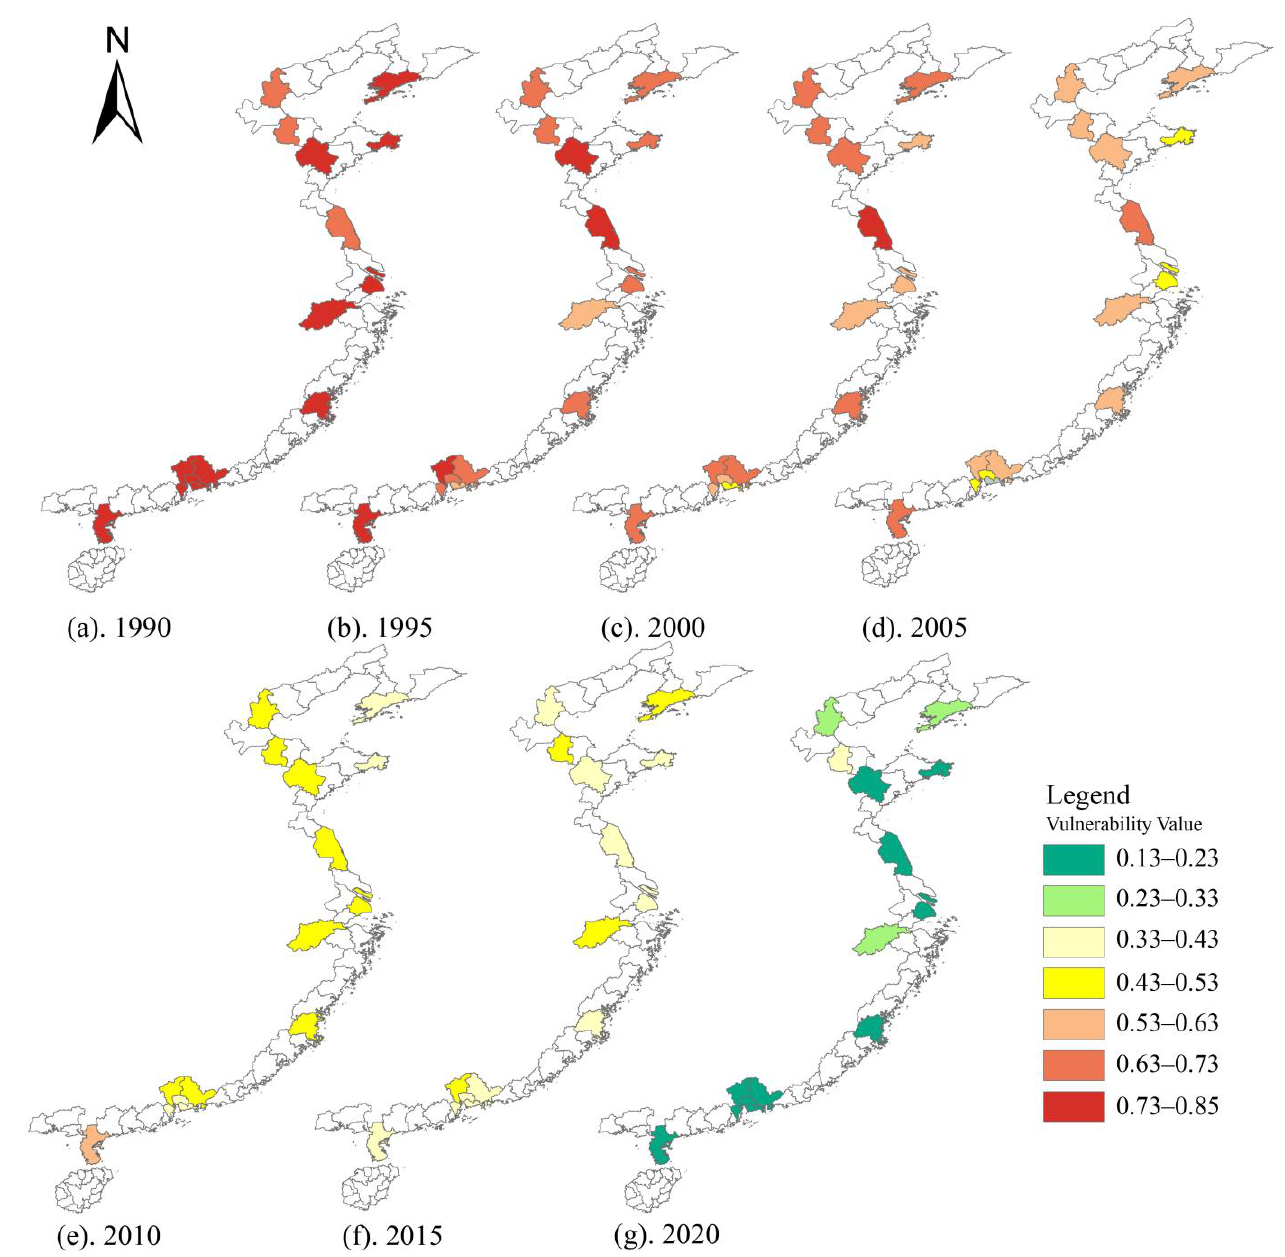
Figure 7. Spatial distribution of vulnerability in 15 coastal cities in China from 1990 to 2020.